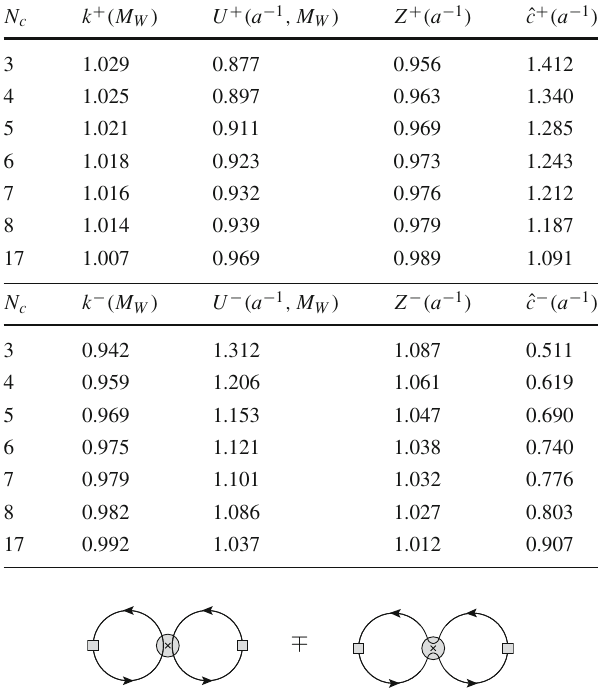
Table2 PerturbativerenormalizationconstantsandRGrunningfactors for the runs with N f = 0 of Refs. [6,7]. Z σ ( a − 1 ) have been computed at one loop in tadpole-improved perturbation theory using the results in [43,44], whereas U σ and k σ are computed using the two-loop MS coupling. Note that the values of Z σ ( a − 1 ) differ from those in Refs. [6,7], where bare lattice perturbation theory was used. Furthermore, the values of k σ and U σ also supersede the ones in Refs. [6,7]. In the evaluation of ˆ c σ ( a − 1 ) we have used (cid:10) as described in Ref. [6] MS